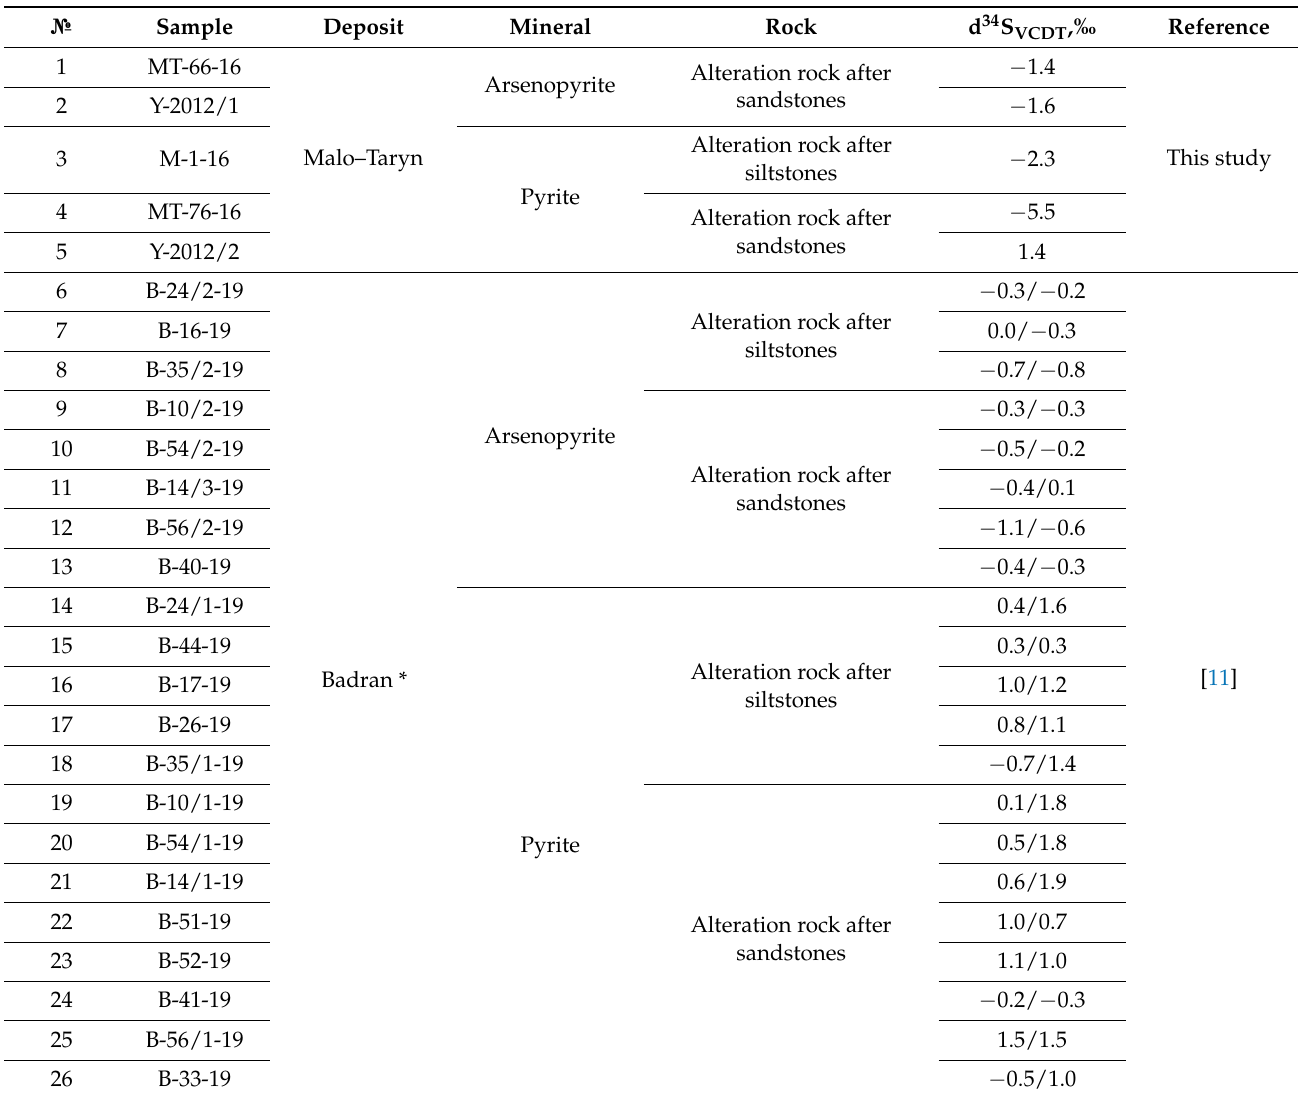
Table 5. Sulfur isotope data of pyrite and arsenopyrite from proximal alteration rock sediment-hosted deposits and intrusion-hosted deposits of the studied OGDs, central